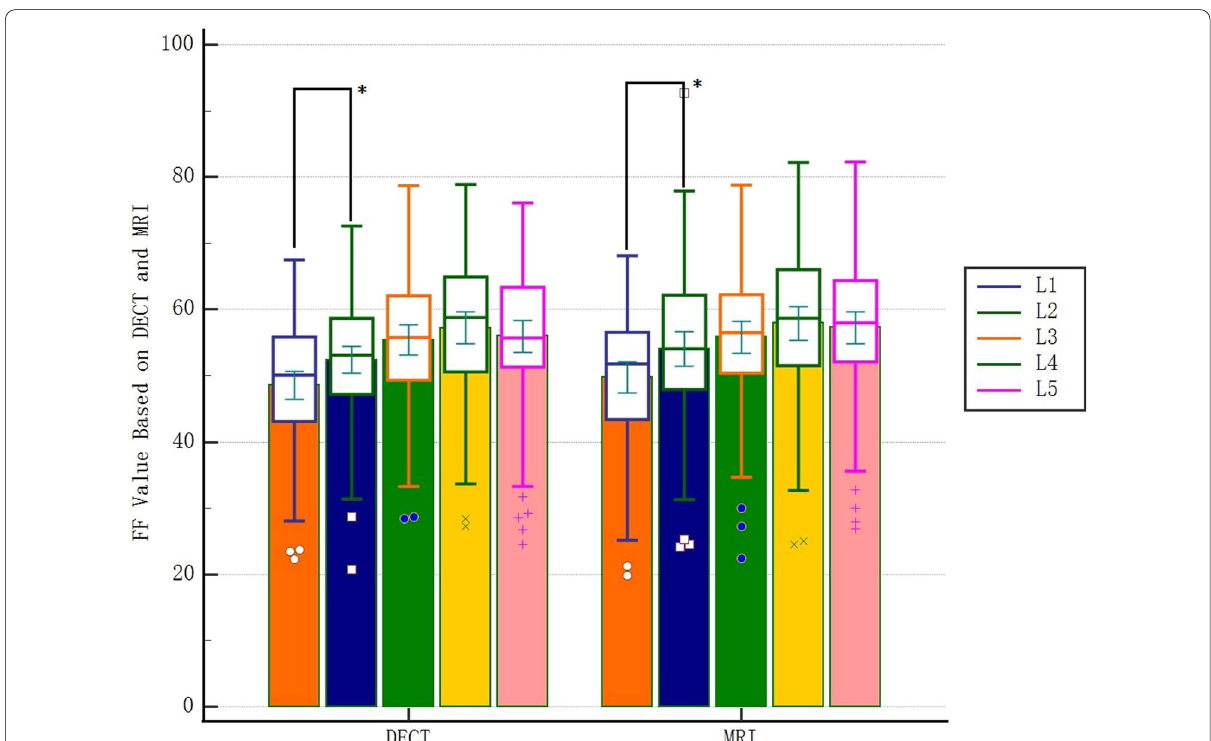
OP osteoporosis, BMI body mass index, BMD bone mineral density, DECT-FF fat fraction based on Dual-energy computed tomography, MRI-FF fat fraction based on magnetic resonance imaging